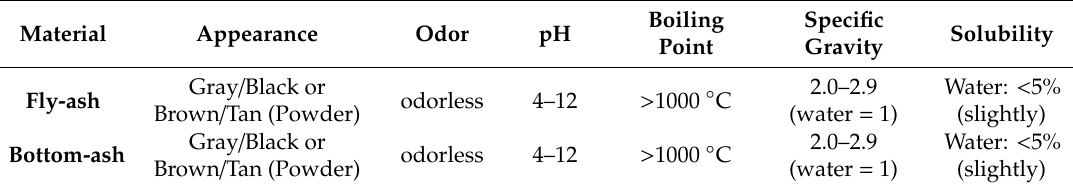
Table 3. Other properties of both fly-ash and